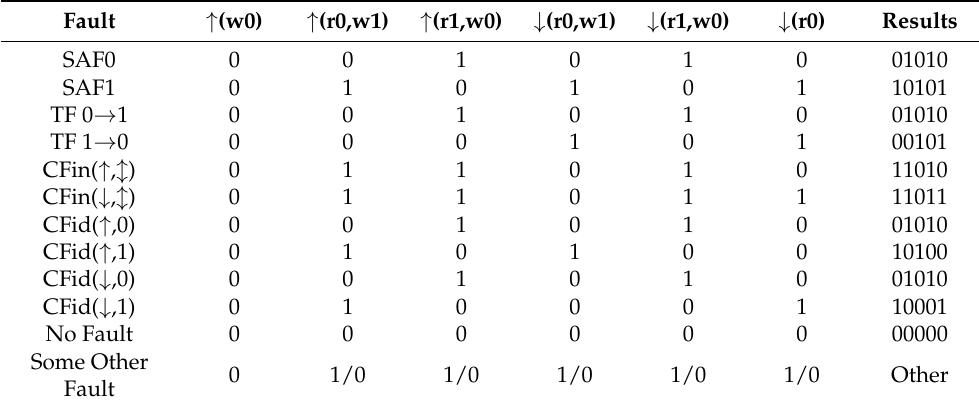
Table 3. Standard testing results of the fault